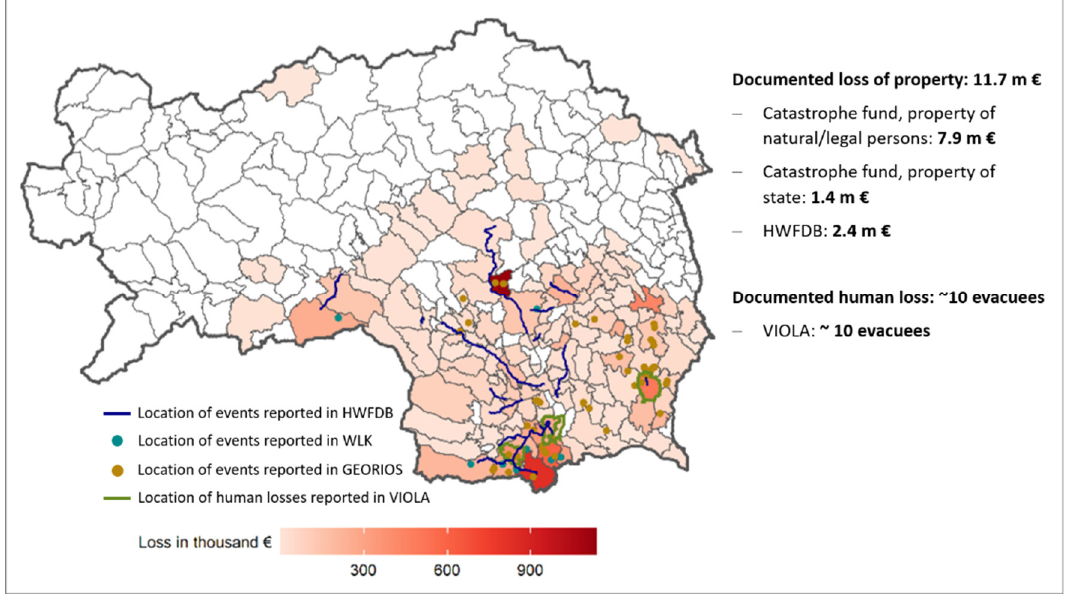
Figure 5. Floods and mass movements in Styria (11–15 September 2014) due to heavy rain: docu- mented events, processes and losses.